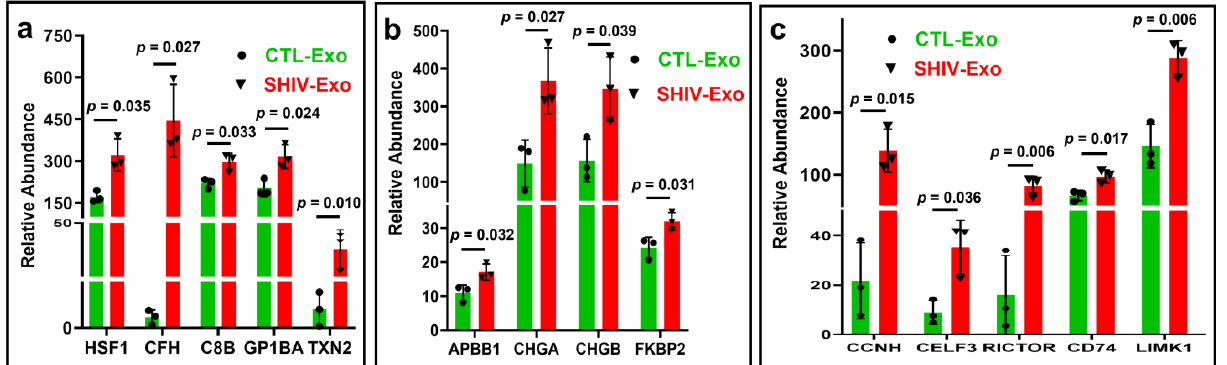
Figure 5. Increased expression of proteins involved in viral reactivation, inflammation, and neuro- pathology-associated interactive/signaling proteins in SHIV-Exo. ( a – c ) Relative protein abundance in CTL-/SHIV-Exo was quantified by proteomic analysis. Proteins that exhibited group differences are shown as bar graphs with green and red for CTL-Exo and SHIV-Exo, respectively. Plasma exo- somes were isolated from three SHIV-infected and three uninfected RM (N = 3/group). Graphs show mean ± SD relative abundance that was calculated from four experimental replicates of each sample. All protein groups ( a – c ) passed the Shapiro–Wilk normality test, and the data sets followed by un- paired t test with Welch correction for normally distributed data. The protein coding gene names are presented here, and they were described in the text. CTL-Exo: Plasma exosomes isolated from uninfected RM; SHIV-Exo: Plasma exosomes isolated from SHIV-infected RM. q-values for: ( a ) all of them are 0.035; ( b ) all of them are 0.040; and ( c ) 0.022, 0.036, 0.017, 0.022, 0.017. Age-adjusted p - values were presented in the Supplementary Materials File S1.